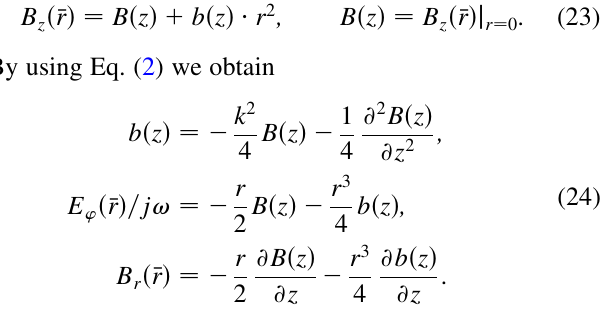
of the TE lens max